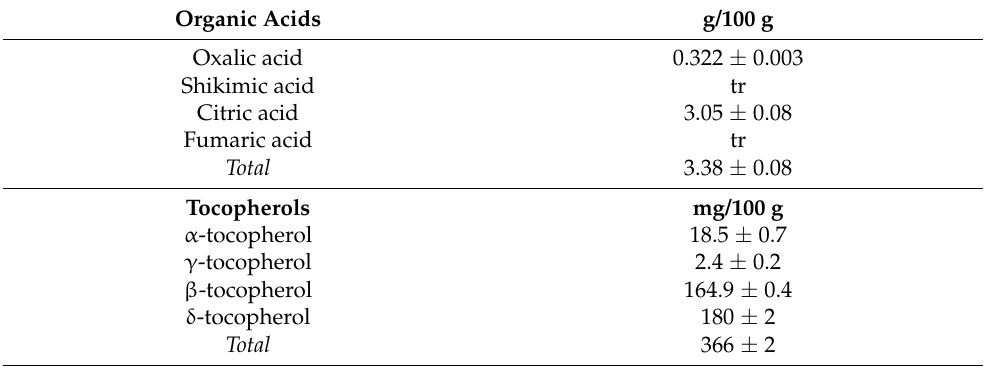
Table 1. Composition in organic acids and tocopherols of the S. odorifera